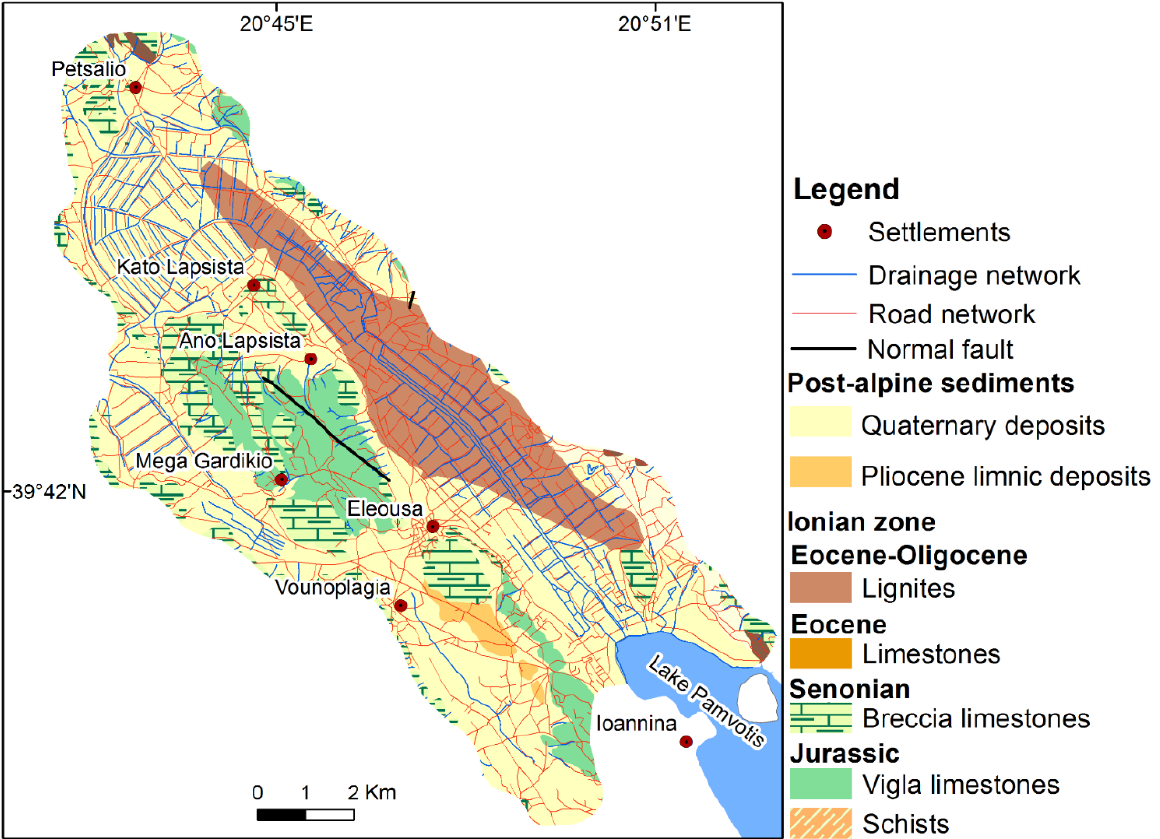
Figure 2. Geological map of the area studied.